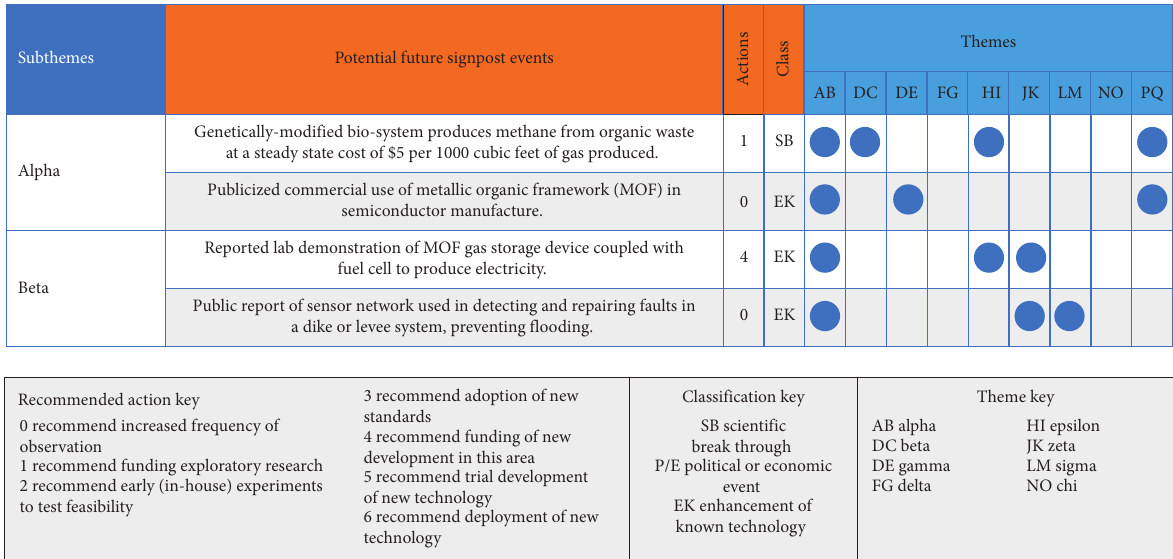
Figure 3: The specific